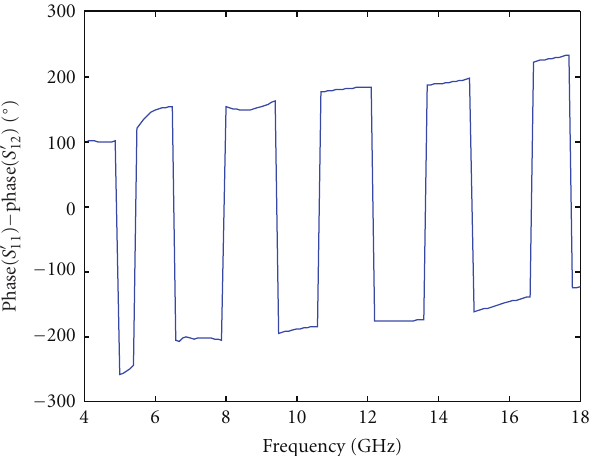
Figure 15: The phase di ff erence between S (cid:2) 11 and S (cid:2) 12 with R = 0 . 3mm − 1